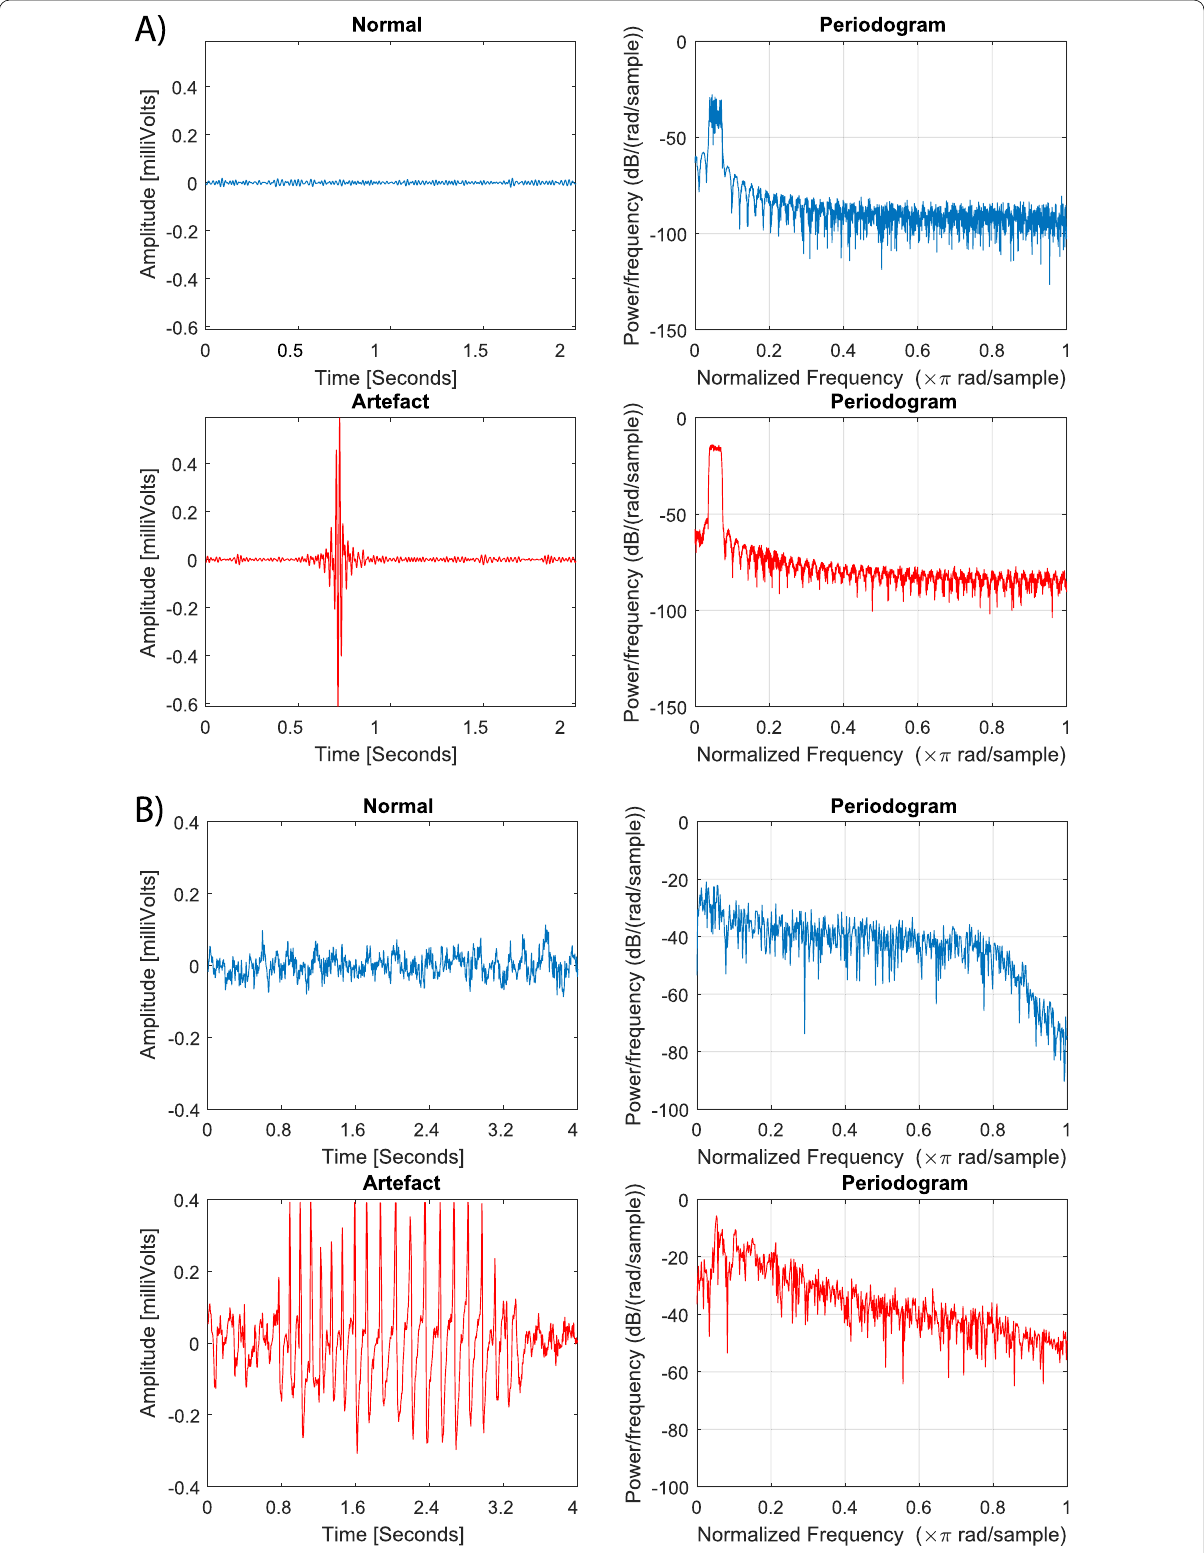
Fig. 1 Examples of signal segments with (red) and without (blue) artefacts along with their respective periodograms for data set 1 ( a ) and data